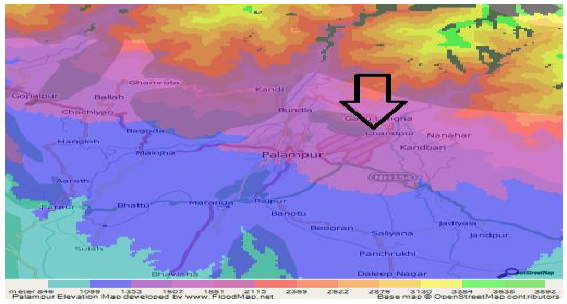
Figure 1: Topographic map of